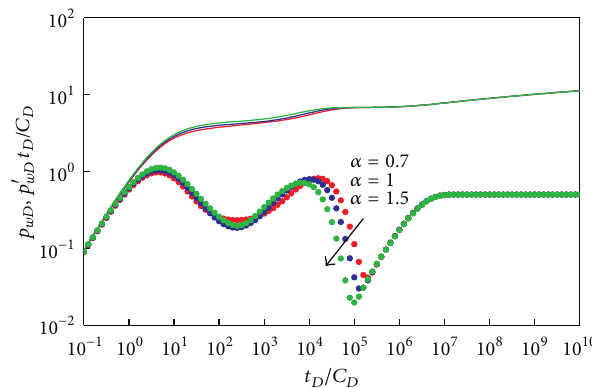
Figure 5: Effect of pore fractal dimension ( 𝐷 𝑓 ) on type curves ( 𝛼 = 1 , 𝛽 = 0.707 , 𝜃 = 1 , 𝑁 = 4 , 𝑀 = 10 , 𝑙 = 0.1 m, 𝑆 = −1 , 𝐶 𝑟 𝑤 and 𝐶 𝑓𝑡 = 1 × 10 −4 MPa −1 ).